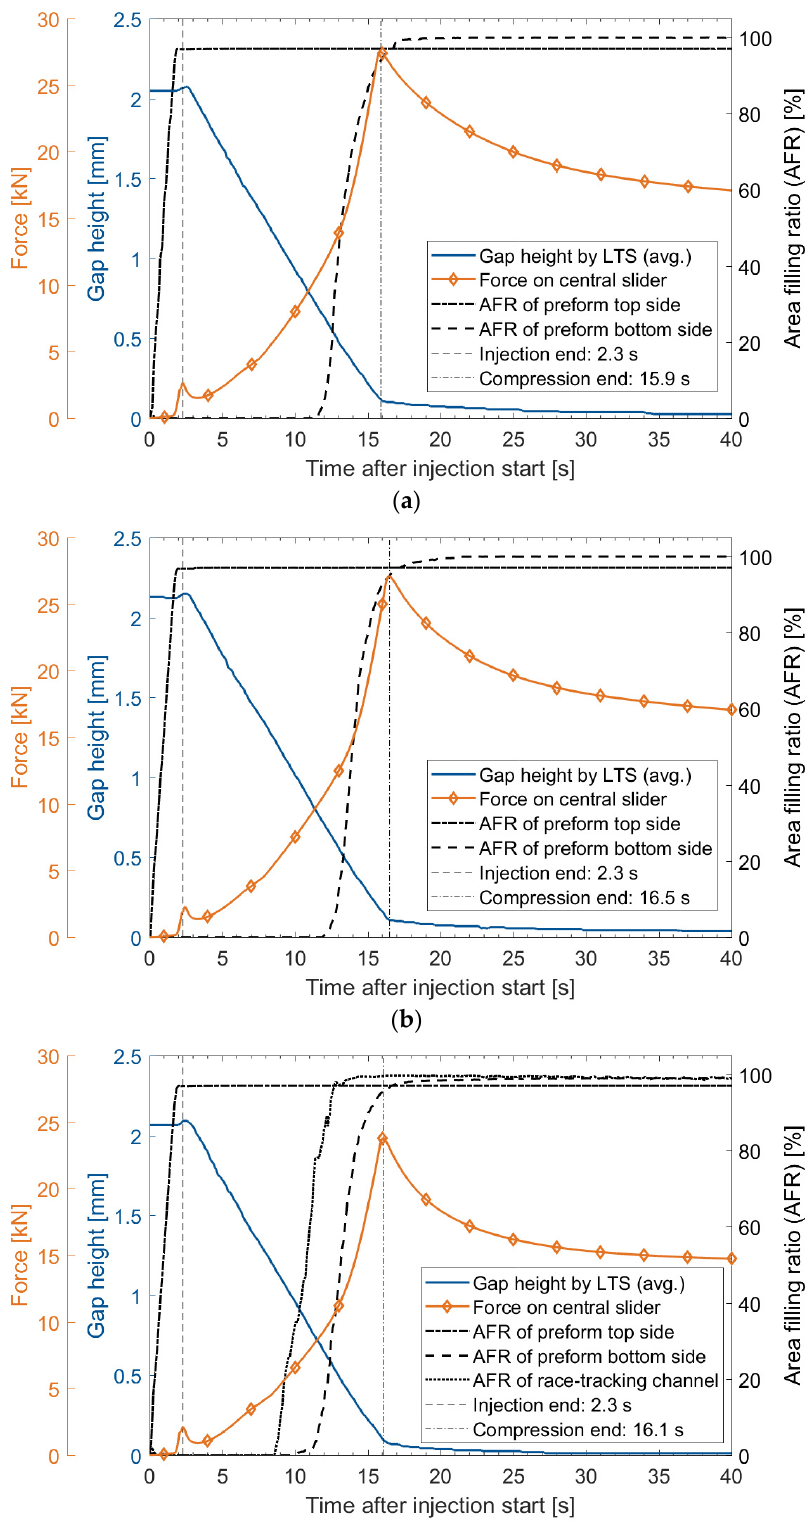
Figure A7. Overview of important process variables during FS-CRTM experiments of the flow control study: ( a ) no race-tracking channel—fcs-#2; ( b ) no race-tracking channel—fcs-#3; ( c ) medium race-tracking channel width—fcs-mrt-#1 (LTS = laser triangulation sensor).